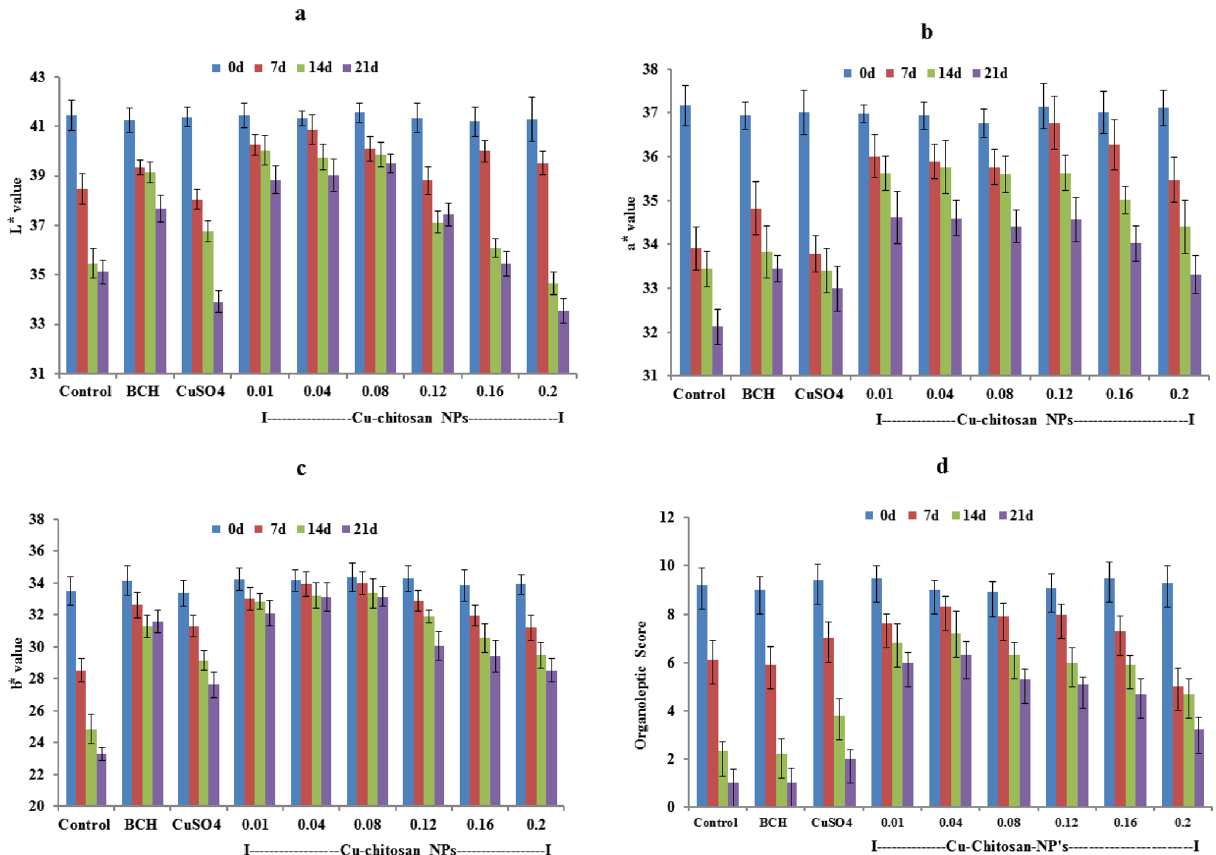
Figure 5. Effect of Cu-chitosan NPs on ( a ) L ⃰ value ( b ) a ⃰ value ( c ) b ⃰ value and ( d ) organoleptic score in tomato stored at room temperature. Each value is mean of triplicates and each replication consisted of 5 tomatoes. BCH (bulk-chitosan) dissolved in 0.1% acetic acid and CuSO 4 (0.01%) dissolved in water. Error bars represents ± SE (standard error).